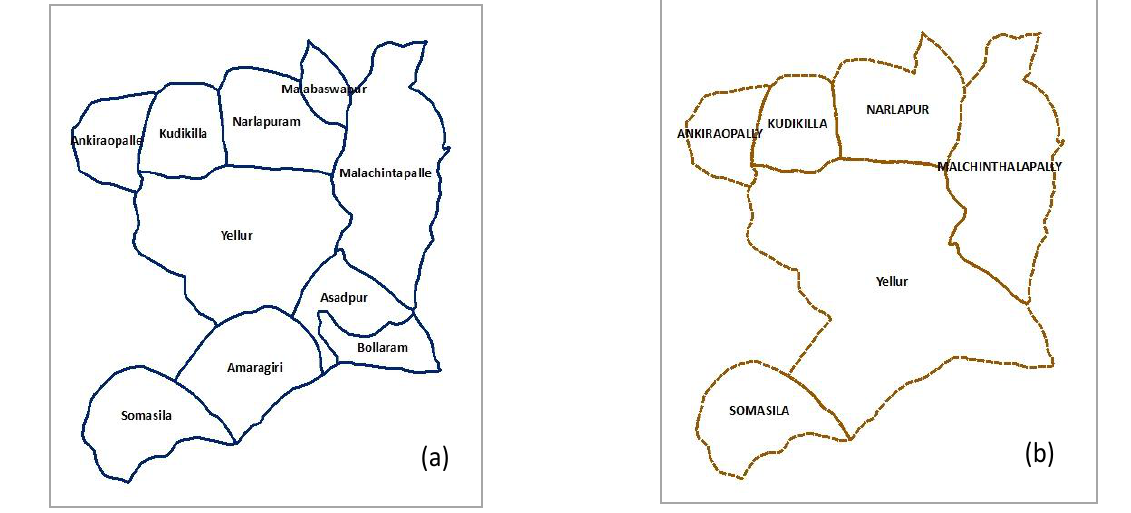
Figure 8: (a) Village boundary of Kollapur mandal and (b) Panchayat boundary of Kollapur